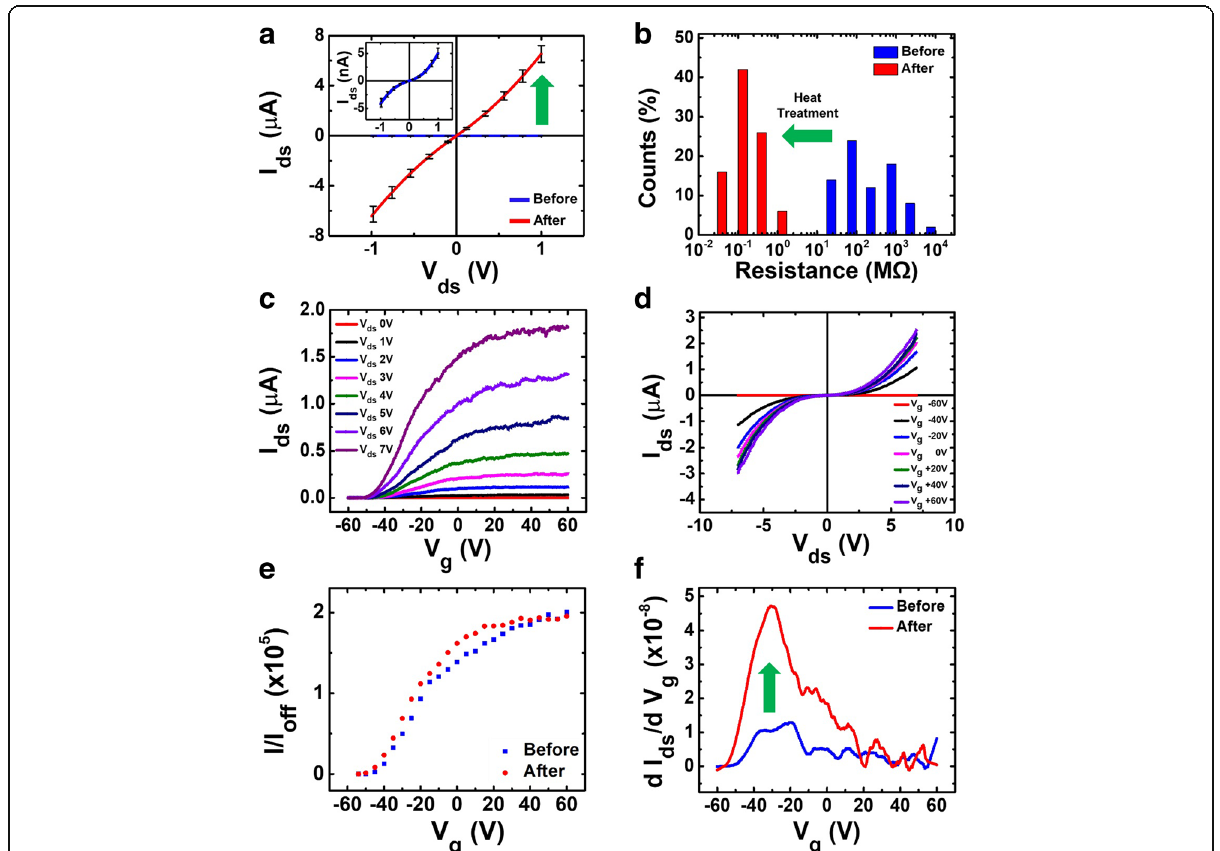
Fig. 4 ZnO NWs network electrical properties after heat treatment. a Typical current-voltage characteristics before and after annealing of pulling speed 2 mm min − 1 . The network channels showed Schottky contact behavior. (inset) I – V characteristics before annealing, magnified. b Resistance frequency distribution of ZnO NWs network pulled at speed of 2 mm min − 1 . Average resistance decreased for about three orders. ( c ) I – V characteristics at different back-gate voltages. V g ranged from − 60 V to 60 V in 20 V steps. d Electrical properties of I ds vs V g after heat treatment. e Comparison of I / I off ratio at different V g values, before and after heat treatment ( V g step = 5 V). f Improved transconductance by heat